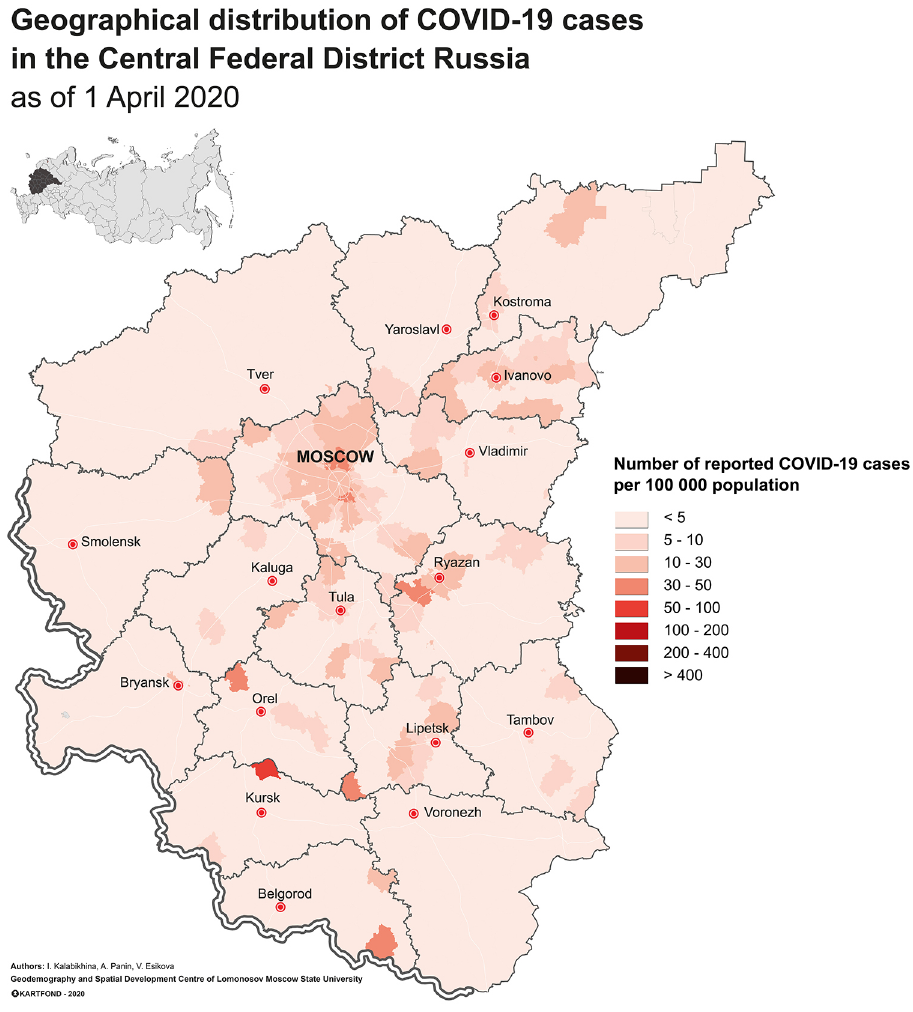
Figure 13. Geographical distribution of COVID­19 cases in the municipalities of the Central Federal District of Russia, number of reported COVID­19 cases per 100 thousand population, 01.04.2020, ac­ cording to Rospotrebnadzor (2020). Source: Compiled by the researchers of the Geodemography and Spatial Development Centre of the Population Department of the Economics Faculty of Lomonosov Moscow State University together with the “Kartfond” research